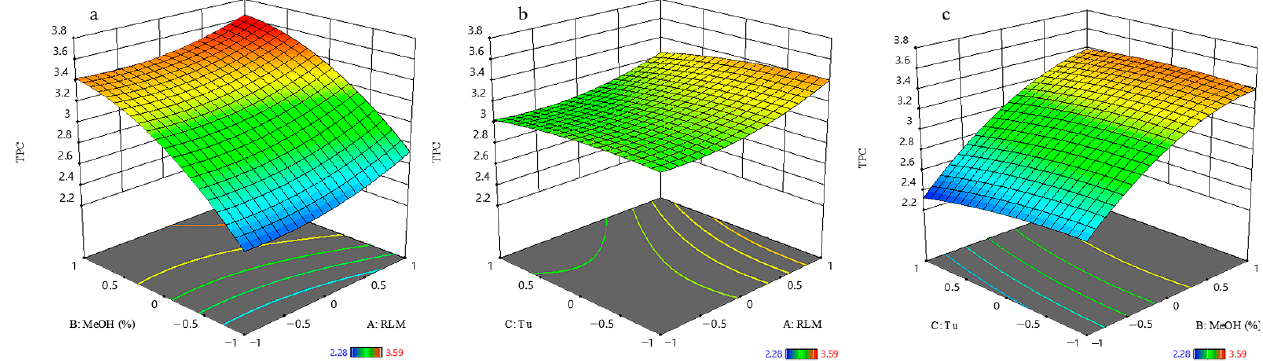
Figure 1. Response surface of total phenolic content: ( a ) as a function of ratio of material to liquid and percentage of methanol; ( b ) as a function of ratio of material to liquid and ultrasonic time; ( c ) as a function of percentage of methanol and ultrasonic time.